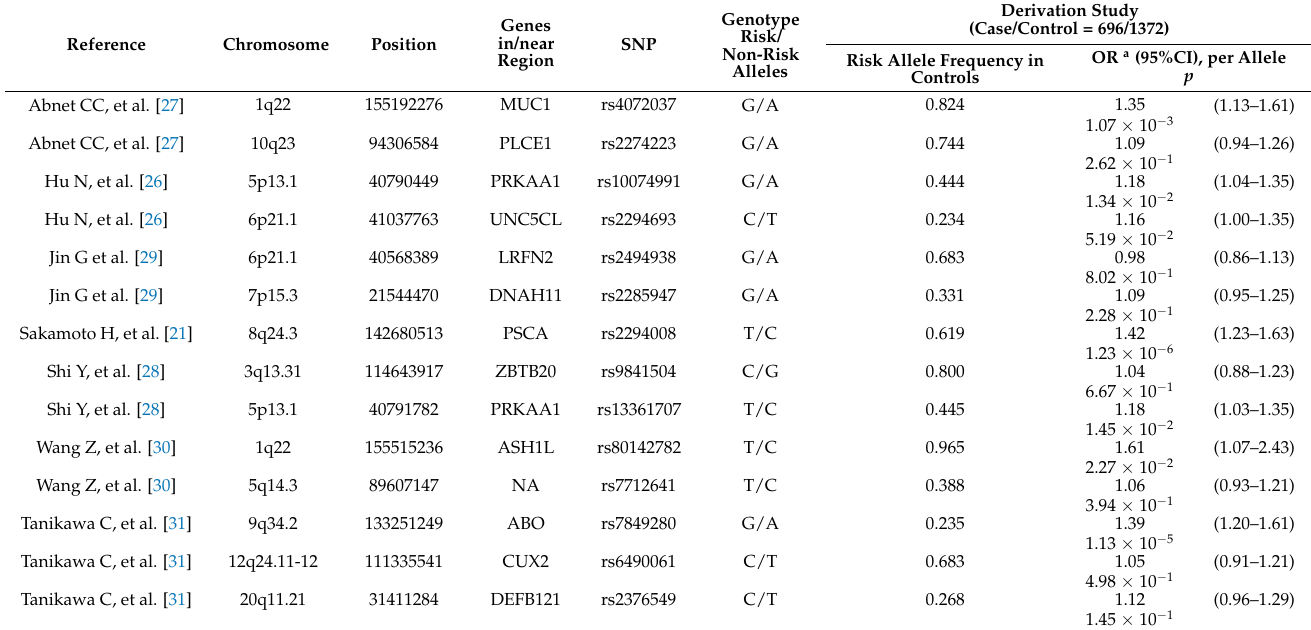
Table 3. Associations with Asian GWAS-identified susceptibility polymorphism in stomach cancer risk (derivation study).